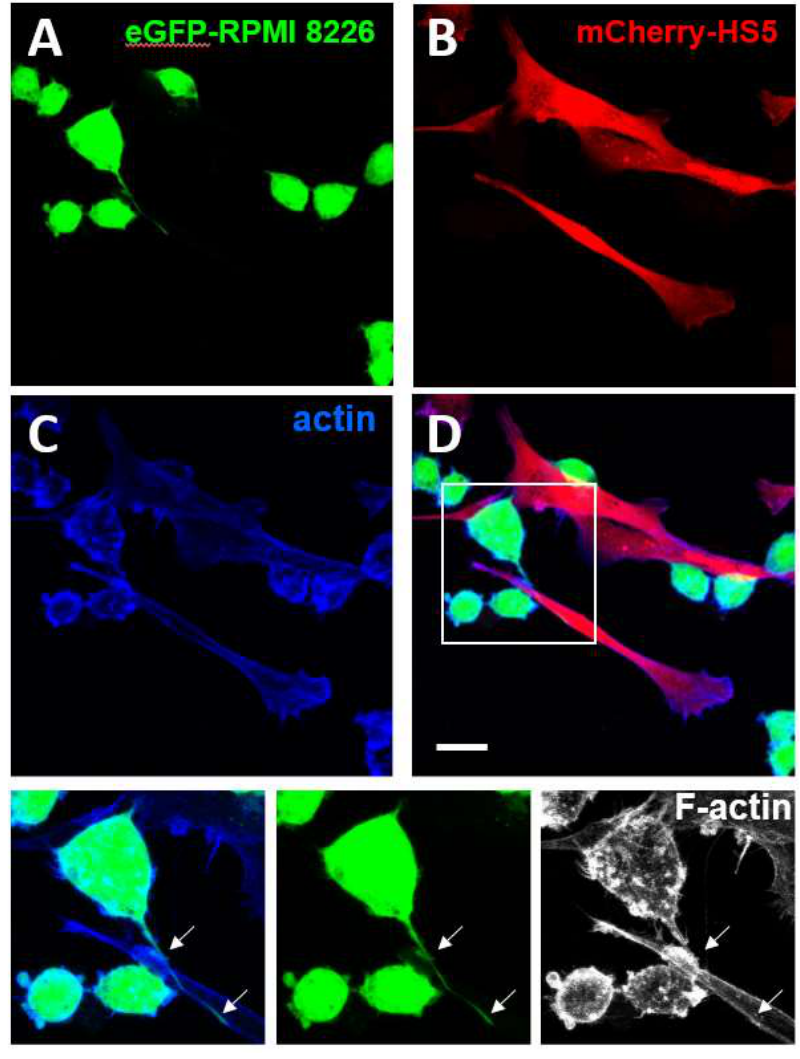
Figure 3. Formation of podia in multiple myeloma cells. The enhanced-Green Fluorescent Protein (eGFP)-expressing multiple myeloma cell line RPMI-8226 (eGFP_RPMI 28226) ( A ) and the monomeric Cherry (m-Cherry)-expressing bone marrow stromal cell line HS5 (mCherry-HS5) ( B ) were generated as previously described [139]. eGFP-RPMI 8226 were co-cultured for three days with mCherry-HS5 cells, fixed with 4% paraformaldehyde and permeabilised with 0.05% Triton X-100 and stained with Alexa 647-Phalloidin to detect the distribution of F-actin ( C ). Merged images are shown in ( D ). Magnification of the boxed areas with eGFP and F-actin staining are shown at the bottom. eGFP-RPMI 8226 cells formed podia (white arrows) elongating along the surface of mCherry-HS5 cells. Bar 10 µm.